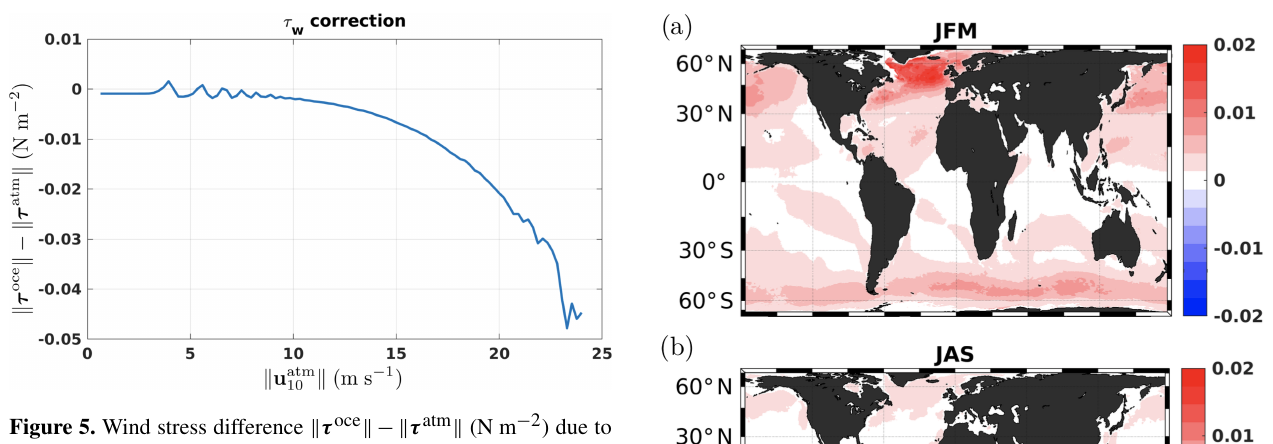
Figure 4. (a) Drag coefficient ( C D ) as a function of the 10m wind speed (cid:107) u atm (black curves represent the mean value, while the vertical bars represent the standard deviation).